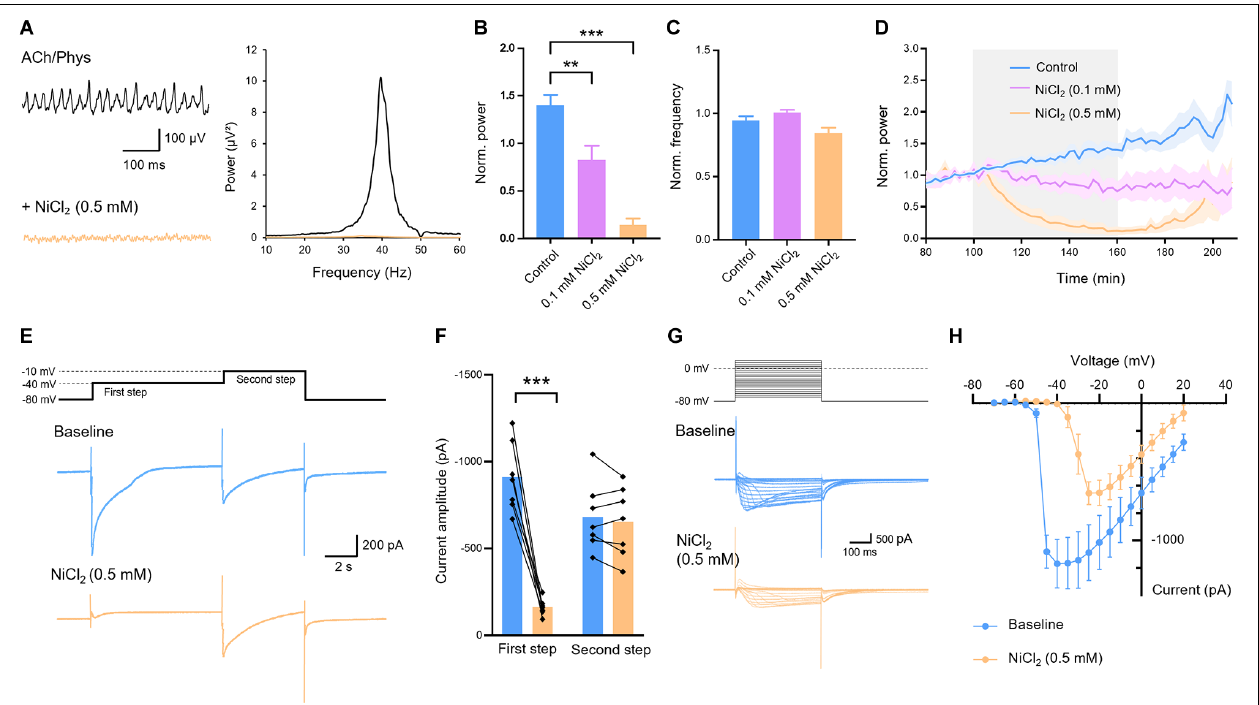
FIGURE 3 | Effect of T-Type calcium channel blocker nickel chloride (NiCl 2 ) on cholinergic gamma oscillations in the rat hippocampus. (A) Original traces (left) and power spectrum (right) of hippocampal gamma oscillations before (black) and after (orange) application of NiCl 2 (0.5 mM). Local field potential traces were lowpass filtered at 200 Hz and bandstop filtered at 50 Hz. (B) Normalized power of cholinergically induced gamma oscillations after bath application of NiCl 2 compared to control. Control (blue): n = 13 slices, N = 9 animals; NiCl 2 0.1 mM (purple): n = 7, N = 3, p = 0.002; 0.5 mM (orange): n = 11, N = 4, p < 0.001. (C) Normalized frequency after application of NiCl 2 compared to control. NiCl 2 0.1 mM (purple): p = 0.406; 0.5 mM (orange): p = 0.088. (D) Normalized power before, during and after bath application (gray) of different concentrations of NiCl 2 (0.1 mM, purple; 0.5 mM orange) compared to control (blue). (E) Low voltage- and high voltage-activated calcium currents recorded by a first depolarizing step from − 80 to − 40 mV and a second step from − 40 to − 10 mV, respectively, of the same cell before (blue) and after (orange) bath application of NiCl 2 (0.5 mM). (F) Amplitudes of low and high voltage-activated calcium currents evoked by the first and second step, respectively, before and after application of NiCl 2 (0.5 mM). First step: p < 0.001. Second step: p = 0.331; n = 7, N = 4, paired t -test. (G) Step protocol (above) and original traces of calcium currents (below) with voltage steps from − 70 mV to +20 mV and holding potential of − 80 mV before (blue) and after (orange)